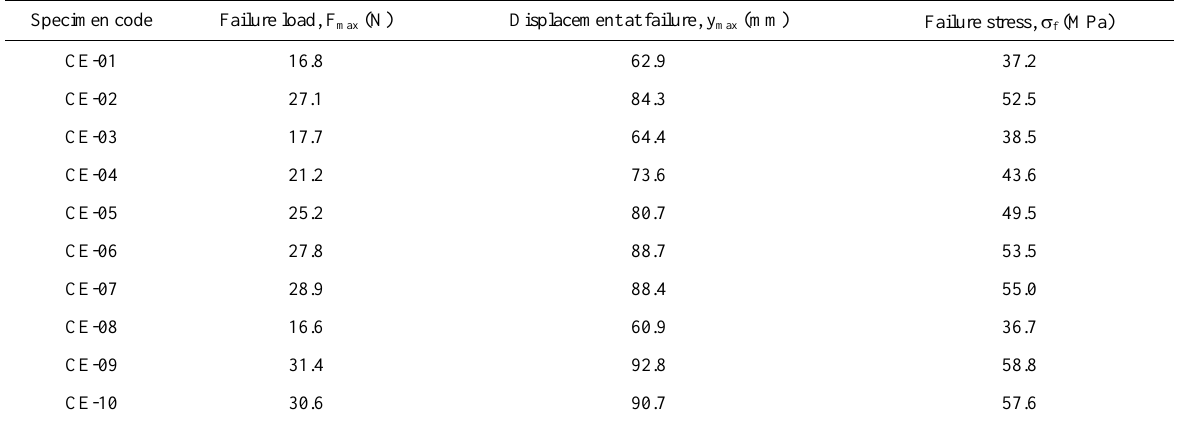
Table 1: Test results for specimens with cut edges,